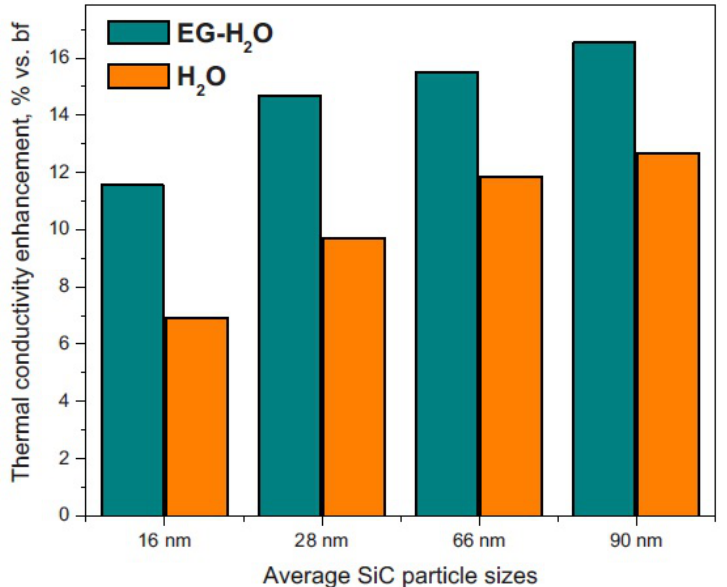
Figure 3. Comparison of the thermal conductivity enhancement in 4 vol.% SiC nanofluids with ethylene-glycol (EG)/ H 2 O and H 2 O as base fluids at various particle sizes. After [59], with permission from